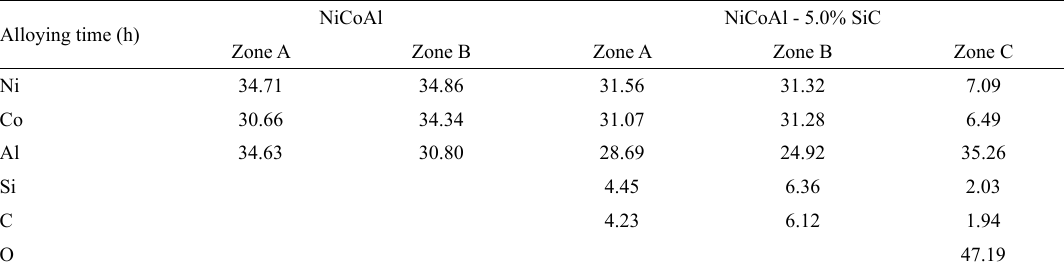
Table 2: Chemical composition of phases identified on sintered samples determined by an EDS-SEM analysis (at.%). Alloying time